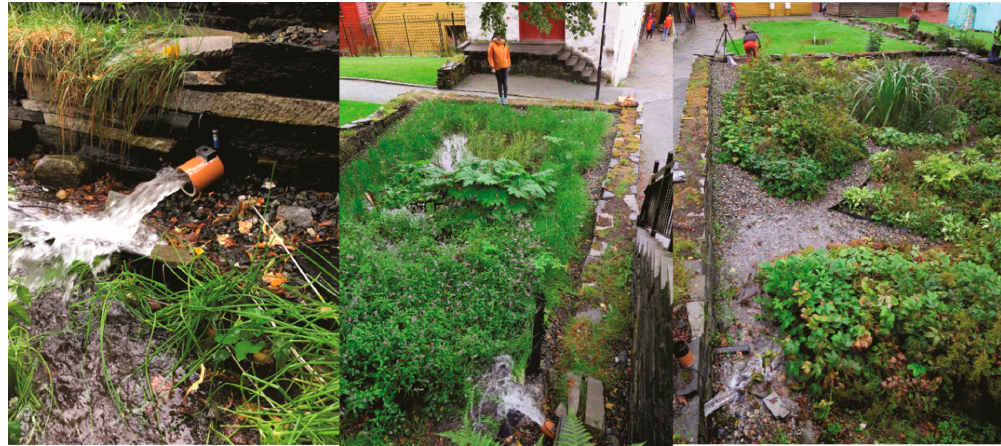
Figure 8. Full-scale infiltration test of the SuDS at Bryggen.